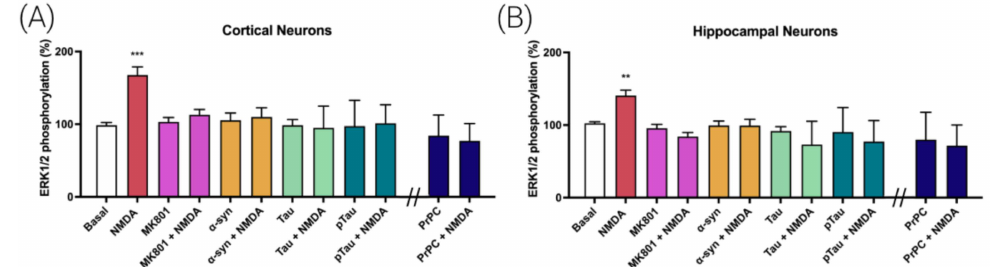
Figure 1. Alpha-synuclein, Tau, pTau and PrPC effect on MAPK signaling pathway activation triggered by NMDA in primary neurons from mice brain. ERK1/2 phosphorylation was analyzed using an AlphaScreen ® SureFire ® kit (Perkin Elmer) in cortical ( A ) or hippocampal neurons ( B ). Primary neurons were treated with vehicle (white) or NMDA (15 µ M, red) or preteated with the selective NMDAR antagonist MK-801 (1 µ M, purple), alpha-synuclein (4 µ M, orange), Tau (1 µ M, green) or pTau (1 µ M, dark green) prior to NMDA addition (15 µ M). Cells transfected with the PrNP (blue, 1 µ g) were treated with the NMDA (15 µ M) or vehicle. Values are the mean ± S.E.M. of 5 independent experiments performed in triplicate. One-way ANOVA followed by Bonferroni’s multiple comparison post hoc test was used for statistical analysis (** p < 0.01, *** p < 0.001 versus basal condition). ANOVA summary: ( A ) F: 7.19 p < 0.001 ( B ) F: 6.68 p <